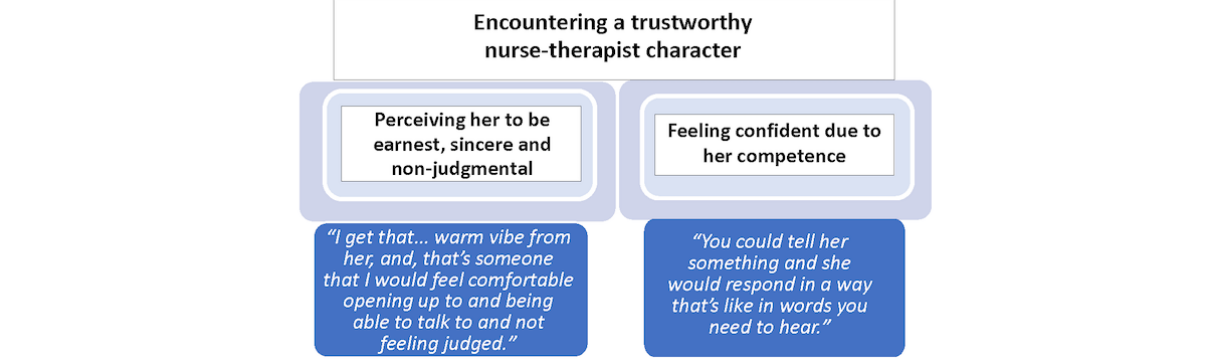
Figure 2. Properties of the category of encountering a trustworthy nurse-therapist character.